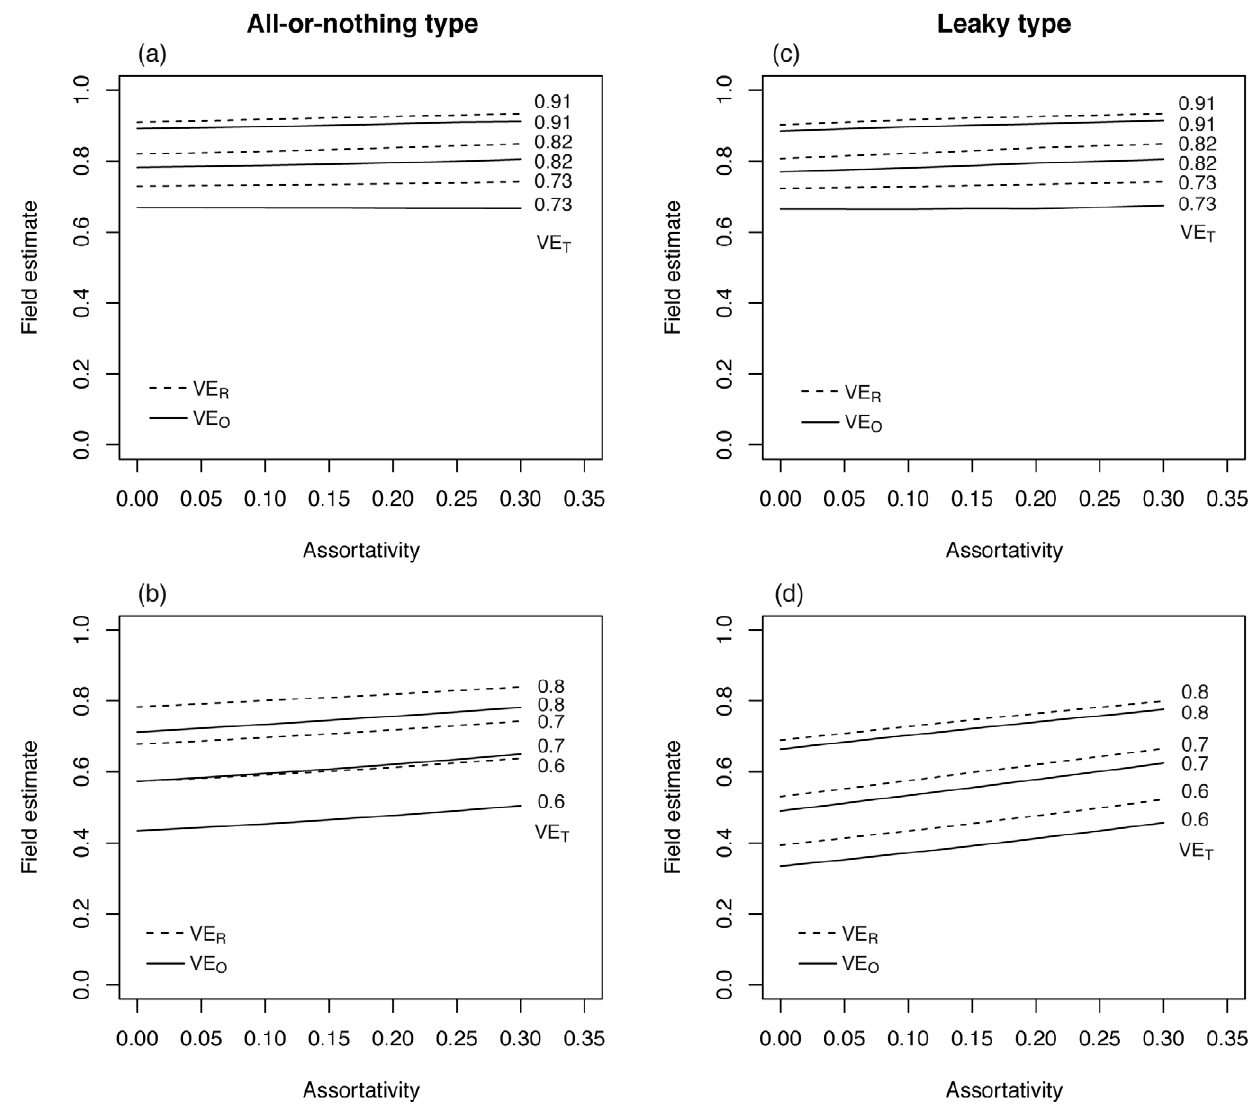
Figure 4. The relationship between vaccine effectiveness against VT (vaccine type) and assortativity coefficient h . Solid line represents vaccine effectiveness based on odds ratio, VE O , while broken line represents that based on relative risk, VE R . Vaccine efficacy against VT is shown at the right end of lines. (a) and (c) show the result from SIR model, while (b) and (d) are from SIS model for Streptococcus pneumoniae . (a) and (b) show the effectiveness of all-or-nothing vaccine (i.e. perfect protection given successful immunization and no protection for unsuccessful vaccination), whereas (c) and (d) show the effectiveness of leaky vaccine (i.e. imperfect protection for all vaccinated individuals).